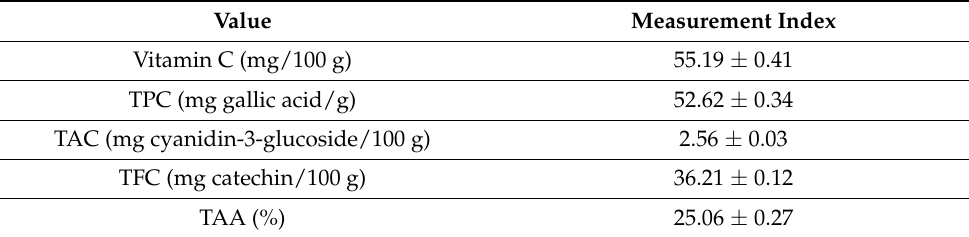
Table 2. Chemical composition and antioxidant activity of JWE powder.